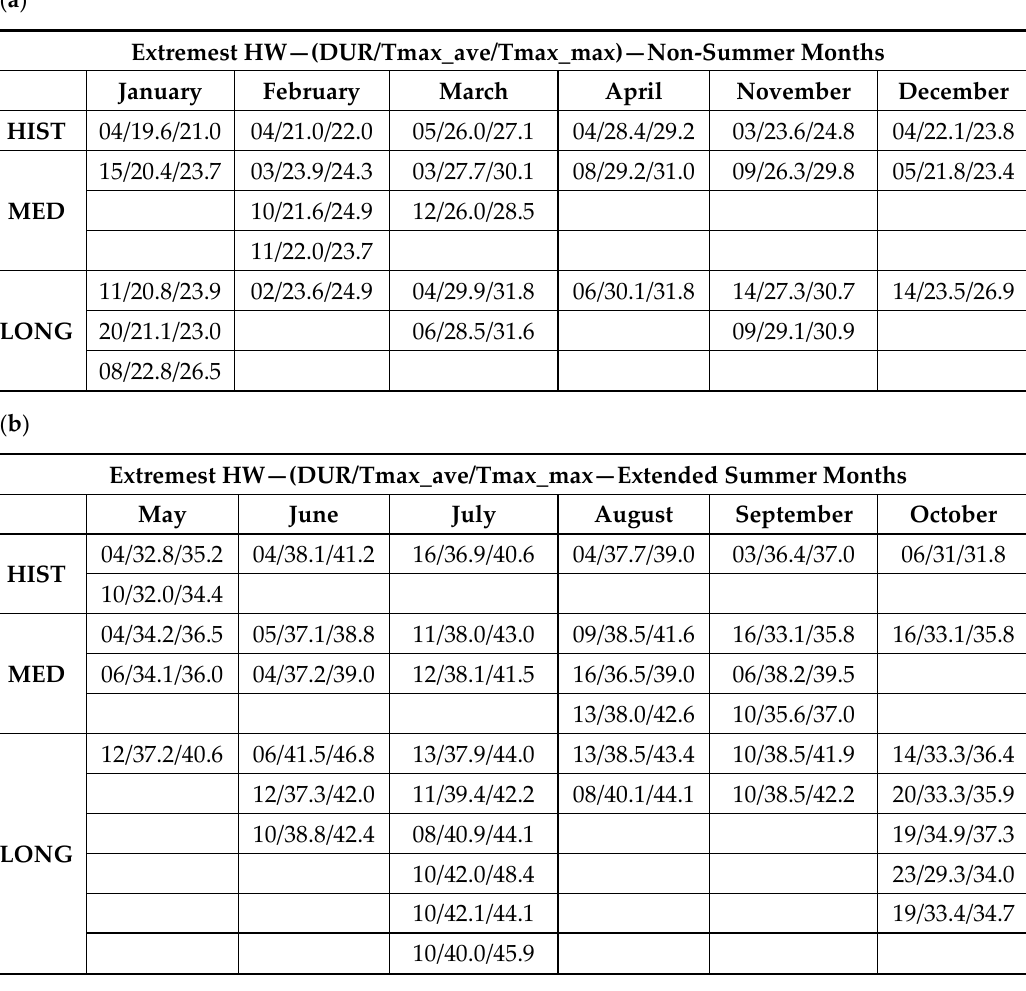
Table 2. Extremest (in terms of duration/intensity) HWs identified for ( a ) non-summer months and ( b ) extended summer months simulated by WRF. Numbers in each cell represent the DUR, Tmax_ave, and Tmax_max for each HW.